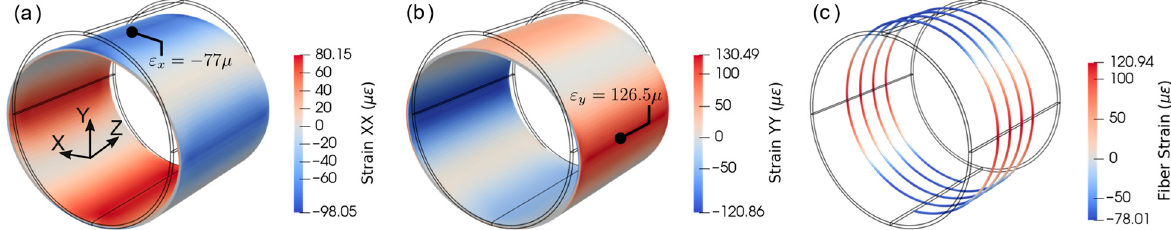
Figure 13. Normal strains distributions: ( a ) strain-XX and ( b ) strain-YY; ( c ) simulated fiber strain distribution. The fiber strain results for the applied displacement of 755 µ m (case 4) are compared